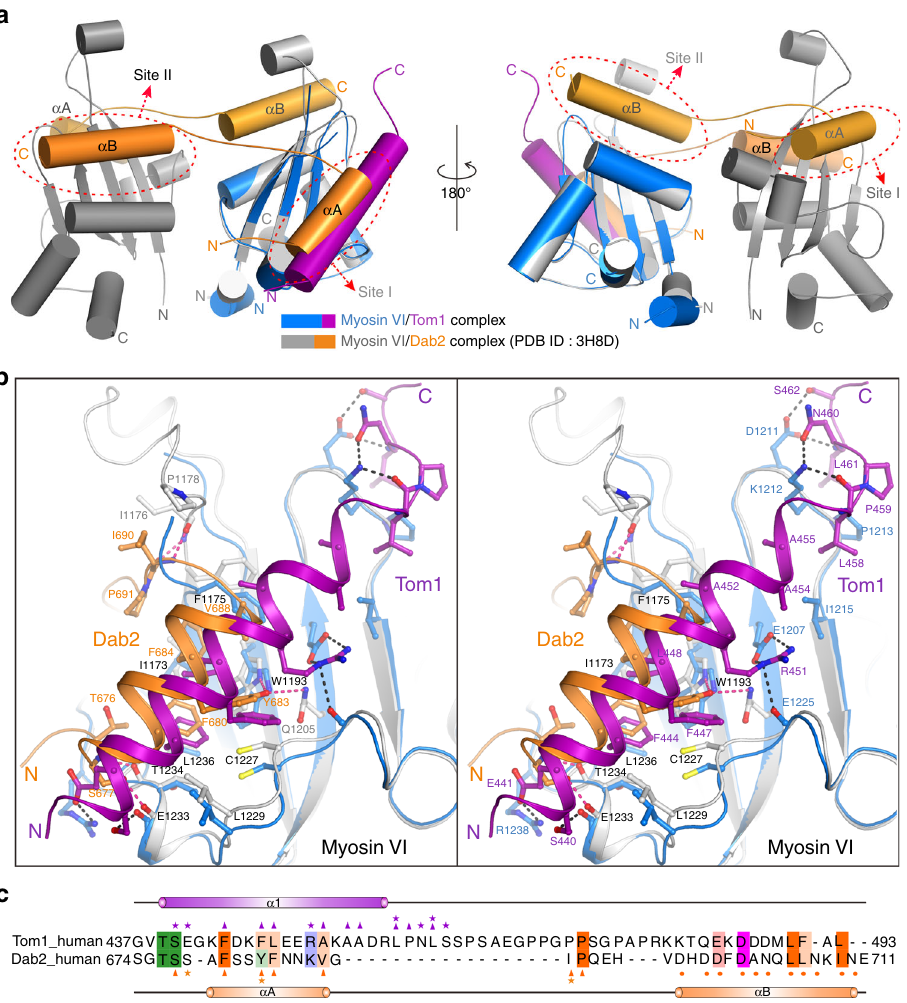
Fig. 4 Comparisons of the Myosin VI/Tom1 and Myosin VI/Dab2 complexes. a The comparison of the overall structures of the Myosin VI/Dab2 complex (gray-orange, PDB ID: 3H8D) and the Myosin VI/Tom1 complex (blue-magenta). In this presentation, the positions of site I and site II in the C-terminal CBD of Myosin VI are further indicted. b Stereo view in the ribbon-stick model showing the comparison of the binding interfaces of the Myosin VI/Dab2 complex and the Myosin VI/Tom1 complex with the same color scheme as in a . The hydrogen bonds and salt bridges involved in the interactions are shown as dotted lines. The binding interface residues of Tom1 and Dab2 are labeled with magenta and orange numbers, respectively. While, the interface residues of the C-terminal CBD of Myosin VI that involved in the interactions with both Tom1 and Dab2, only for the interaction with Tom1 or Dab2, are labeled with black, blue, and gray numbers, respectively. c Structure-based sequence alignment of Tom1(437 – 493) and the Myosin VI-binding region of Dab2. In this structure-based sequence alignment, the conserved hydrophobic residues, polar neutral residues, positively charged residues and negatively charged residues are colored in orange, green, blue, and magenta, respectively. Key interface residues of Tom1 involved in the interaction with the site I of the C-terminal CBD of Myosin VI through the polar interactions and the hydrophobic interactions are further labeled with magenta stars and triangles, respectively, and that of Dab2 are highlighted with orange stars and triangles. Meanwhile, key interface residues of Dab2 that are critical for binding to the site II of the C-terminal CBD of Myosin VI, are labeled with orange